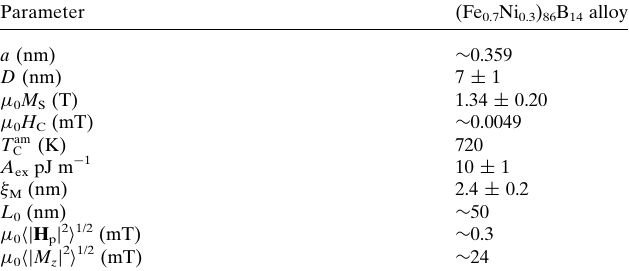
Table 1 Summary of the structural and magnetic parameters for (Fe 0.7 Ni 0.3 ) 86 B 14 alloy (HiB-NANOPERM-type soft magnetic nanocrystalline material) determined by wide-angle XRD, magnetometry, DTA, TMGA and SANS.